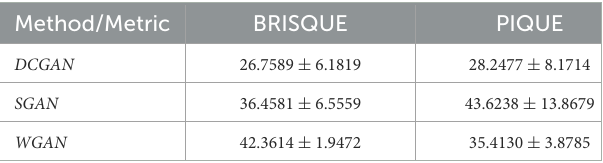
TABLE 1 Comparison of different GAN